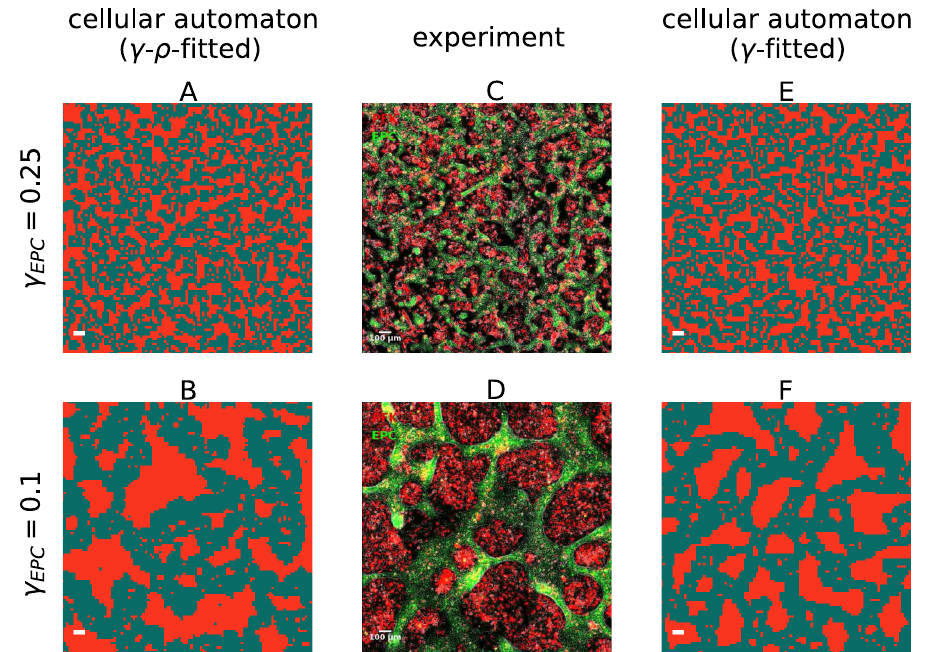
Fig 7. The cellular automaton with γ - ρ -fitted parameters reproduces the morphology and size distribution of the cell clusters ρ in the experiments of Me´hes et al. [20] of EPC (green) with PFK (red) closer than the cellular automaton with the γ -fitted parameters. The snapshots of the cell mixtures A, C, E of the first row are taken at a segregation index of EPC γ EPC = 0.25, at the start of the experimental recording, while the snapshots B, D, F in the second row are at a segregation index of EPC γ EPC = 0.1, at the end of the recording. A and B show the cellular automaton with optimised parameters, C and D show the experiments and are taken from video S5 in Me´hes et al. [20], and E and F show the cellular automaton with the Δ γ fitted parameters. The snapshots A, B, E and F show a detail from the simulations, such that approximately 100 2 cells are visible, to match the spatial scale of the snapshots C and D of the